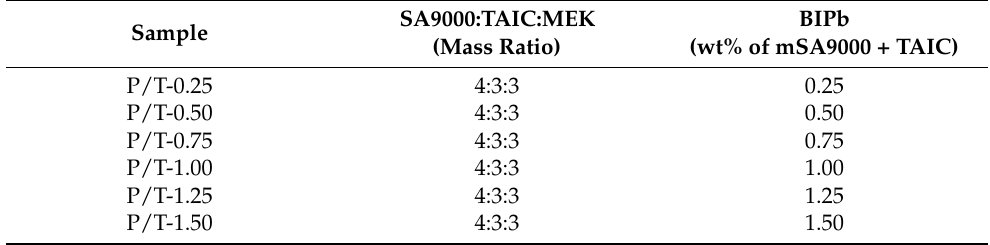
Table 1. The composition of casting samples.